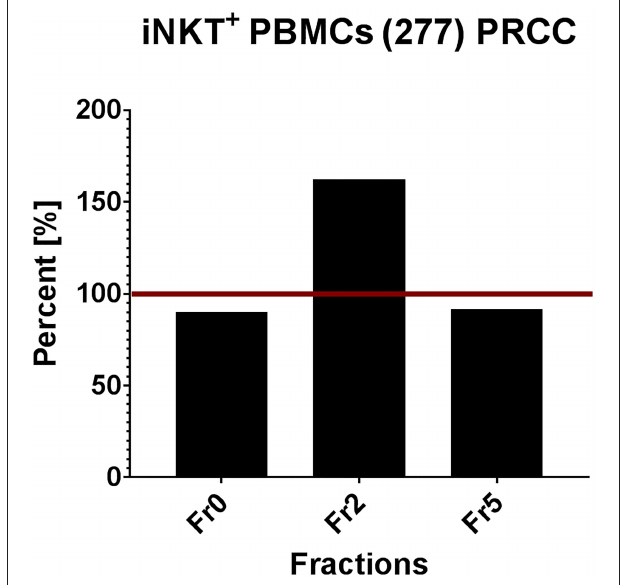
FIGURE 7 | Tumor own lipids (277) induce proliferation of iNKT cells from patient-derived PBMCs ( n = 1). Quantification of flow cytometric analysis showing the percentage of iNKT cells in a patient-derived PBMC population stimulated with lipid fractions 0, 2, and 5 relative to the positive control α -GalCer (defined as 100%, red